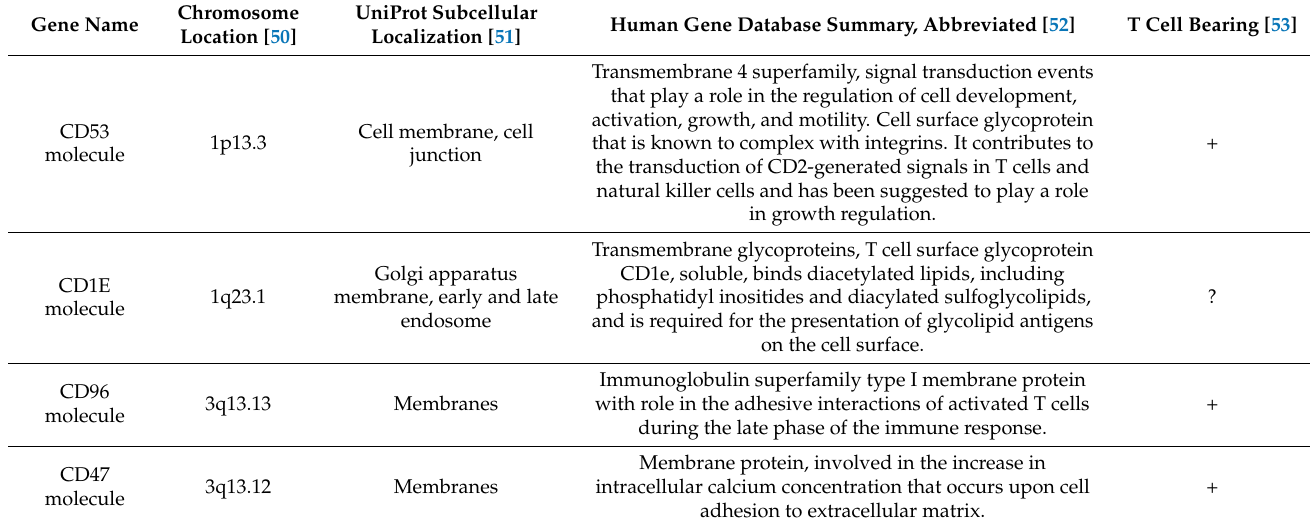
Table 2. List of significantly differentially expressed CD markers. Gene name, chromosomal localization, subcellular localization of the final protein, functional description of the gene, and presence in T cells (“+”: present, “-”: absent, “?”: ambiguous) are